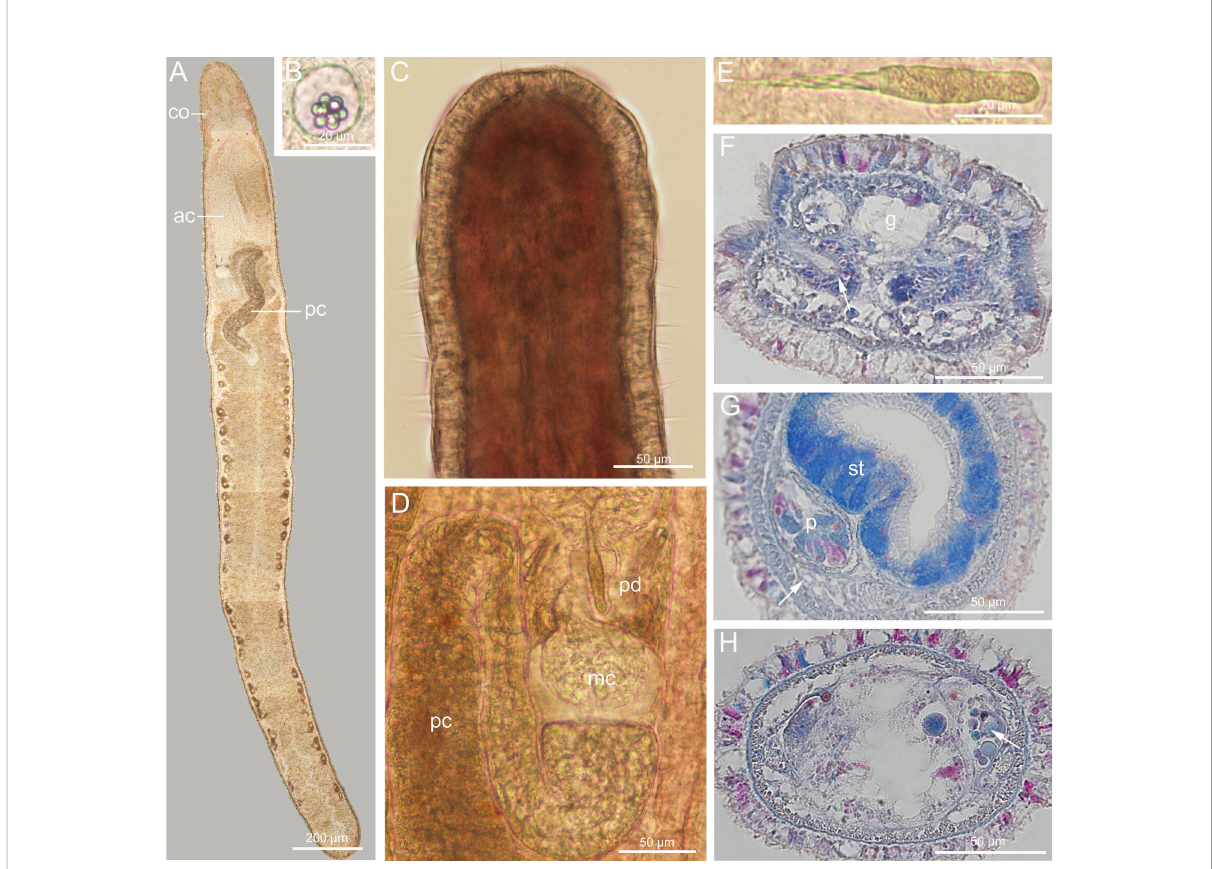
FIGURE 8 Ototyphlonemertes ( Procso ) similis sp. nov. (A) Composite photomicrograph of a squeezed specimen; (B) statolith; (C) dorsal view of head; (D) photomicrograph of partial proboscis from squeezed specimen; (E) central stylet and basis; (F) transverse section through a cerebral organ (arrowed); (G) transverse section through stomach region, nephridia indicated by arrow; (H) transverse section through ovaries (arrowed). ac, anterior chamber of proboscis; co, cerebral organ; g, cephalic glands; mc, middle chamber of proboscis; p, proboscis; pc, posterior chamber of proboscis; pd, proboscis diaphragm; st,